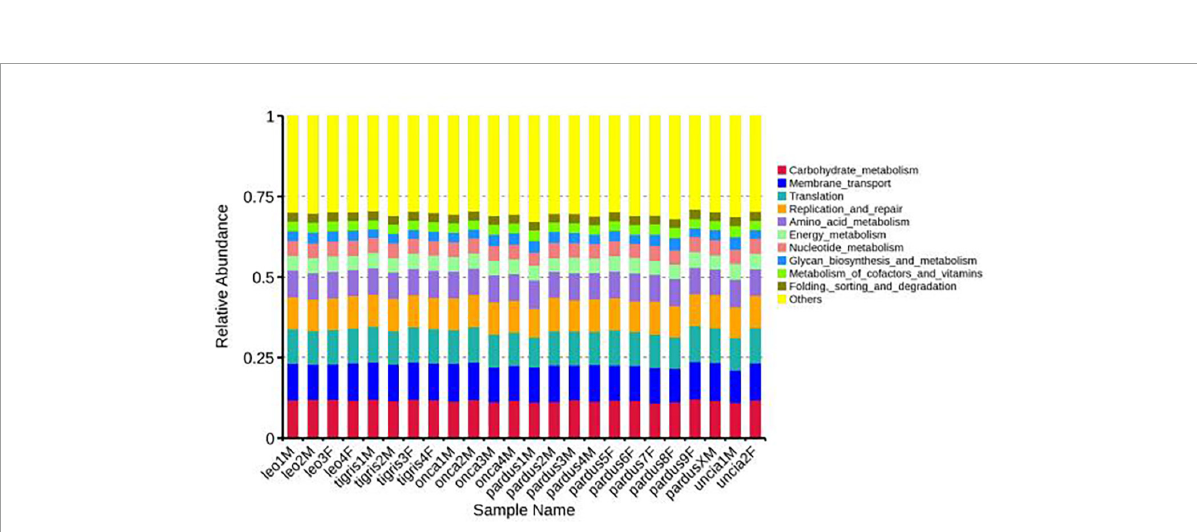
FIGURE4 Relative functional abundances of fecal microbes annotated at the KEGG level